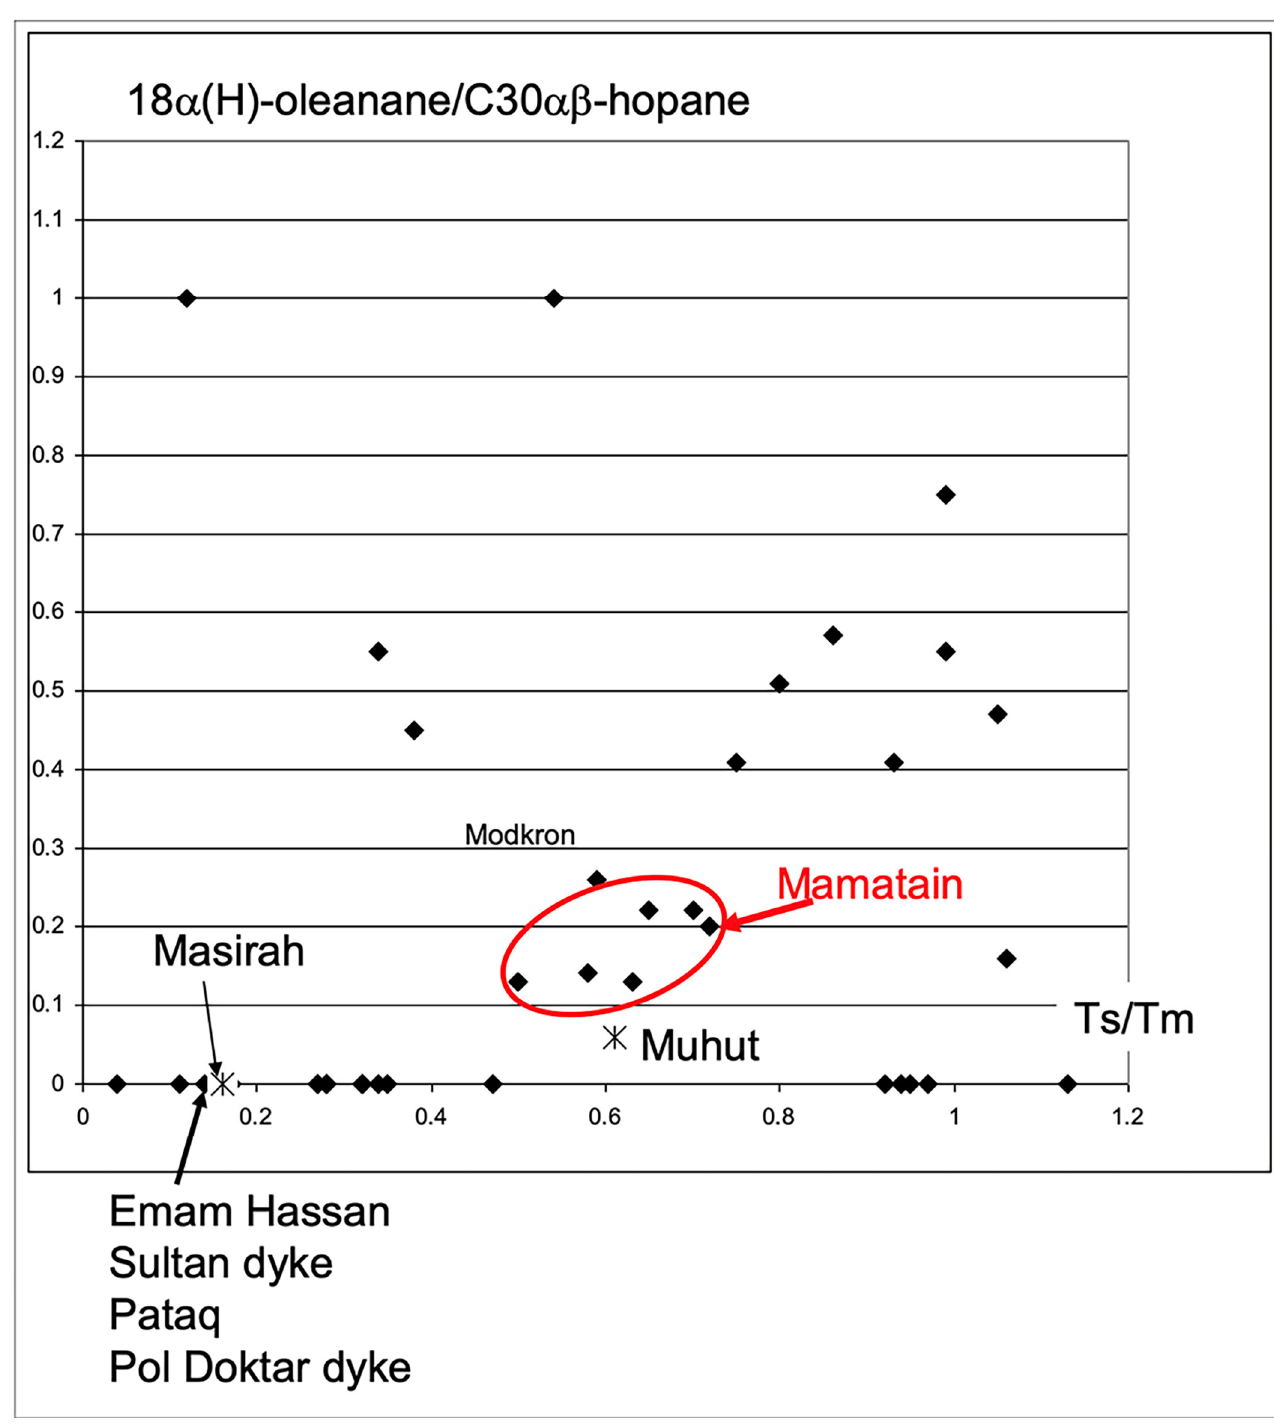
Figure 12. 18 α (H)-oleanane/C30 αβ -hopane vs. Ts/Tm: comparison of Muhut and Masirah bitumens to oil seeps of Iran.